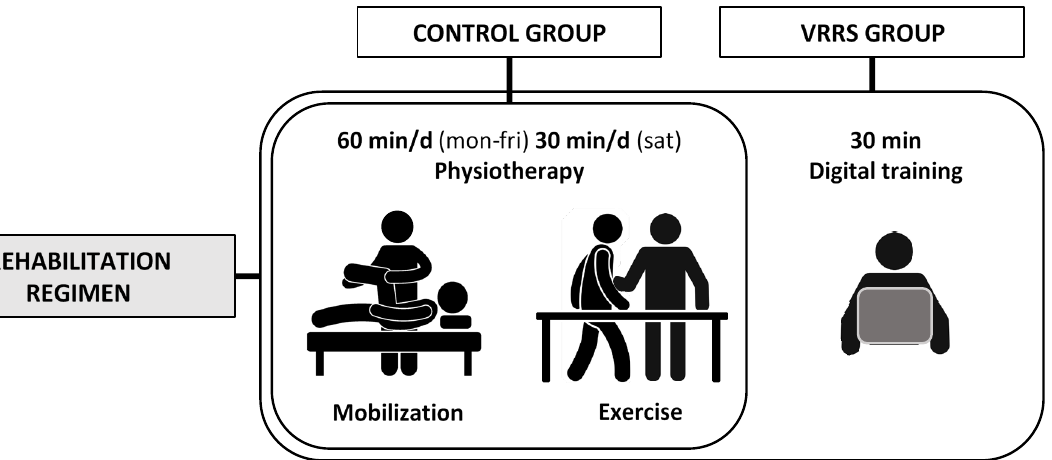
Figure 1. Rehabilitation regimen after THA. During the inpatient post-operative period, patients received 60 min/d (Monday to Friday) and 30 min/d (Saturday) of physiotherapy, consisting of therapeutic exercise and passive mobilization. Only the VRRS group received 30 min of digital training on the use of the VRRS home rehabilitation system in addition to the physiotherapy.